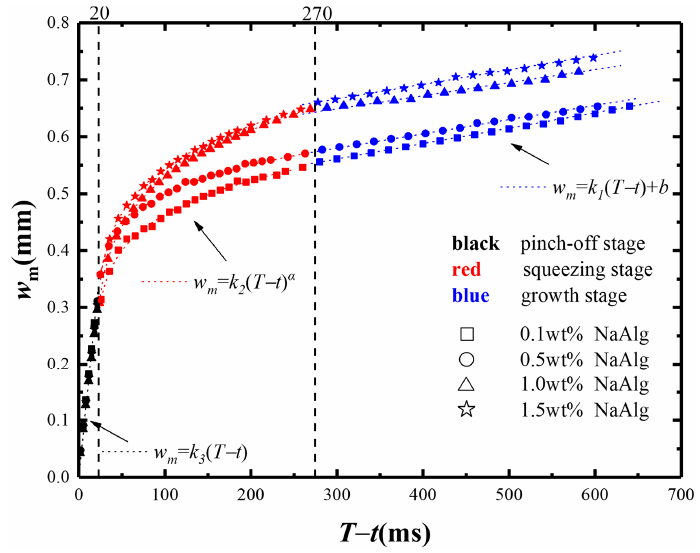
Figure 6. The minimum neck widths w m versus the remaining time T − t with four different mass fractions of NaAlg solution ( Q d =2 mL/h, Q c = 20 mL/h). In Figure 6, the data in growth, squeezing, and pinch-off stages were signed by the colors of blue, red, and black, respectively. It was true that the minimum neck width w m in different evolution stage obeyed the dissimilar evolution mechanism. In the growth stage, the minimum neck width of the neck was linear with remaining time: w m = k 1 ( T − t ) + b . In the squeezing stage, the minimum width was power–law dependent with the re- maining time: w m = k 2 ( T − t ) α . In the pinch-off stage, the minimum neck width transitioned from a power–law relationship to another linear relationship with remaining time: w m = k 3 ( T − t ). This pattern was observed for NaAlg solutions with different mass fractions and different flow ratios ( Q d / Q c ). In the growth stage, the head of micro-droplet expanded downstream slowly and then formed a shallow neck gradually. The growth stage occupied a much longer time for micro-droplet formation compared with other two stages during one period. The mini- mum neck width w m had a linear relation to the remaining time T − t (Equation (5)). With the remaining time T − t increasing, the minimum neck width w m increases. This law also had been found in other researches on both the Newtonian fluids [31,32] and non-Newto- nian fluids [21]. ( ) 1 m w k T t b = − + (5) Subsequently, in the squeezing stage, the continuous phase pushed the head of mi- cro-droplet downward along the microchannel to shrink being a visible neck and decrease the minimum neck width w m . Finally, in the pinch-off stage, the viscous force retarded the